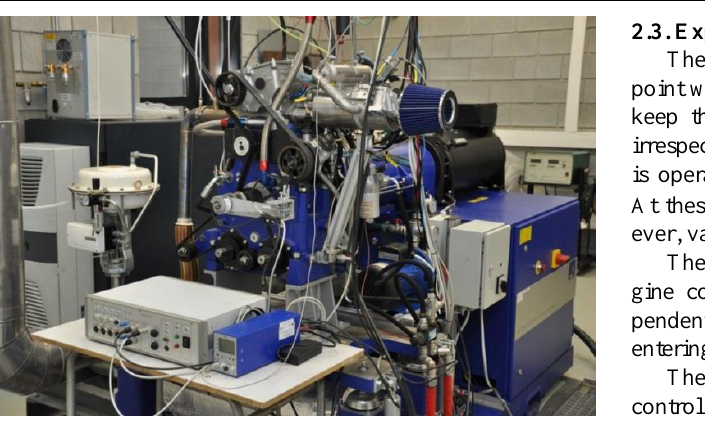
Fig. 1. Engine research test stand at Lublin University of Technology Table 2. Parameters of the research engine